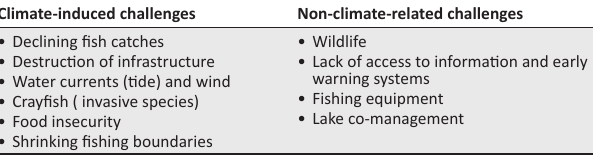
TABLE 2: Challenged experienced by fishers in Sanyathi fishing